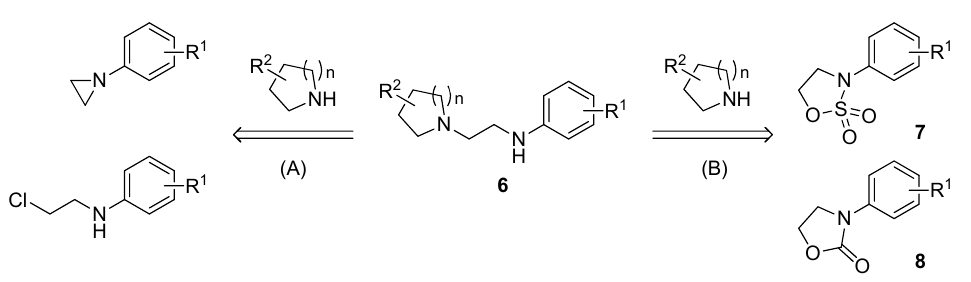
Figure 3. Possible synthetic routes to N -aminoethyl cyclic amines having scaffold 6